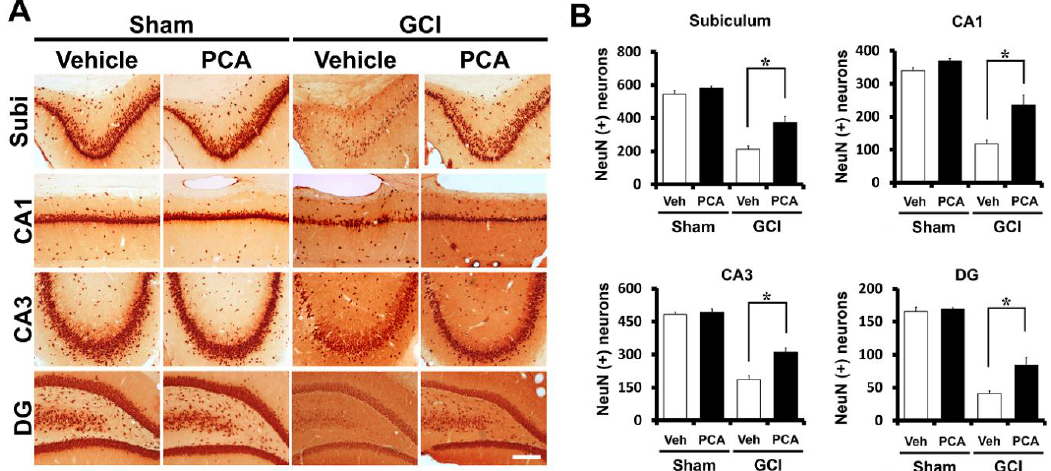
Figure 2. PCA treatment promotes neuronal survival following ischemia. Ischemia-induced neuronal loss was measured by NeuN staining at one week after global ischemia or sham operation. Figure ( A ) representative photomicrographs show significant neuronal loss in the CA1, CA3, subiculum, and DG after ischemia ( n = 9). However, ischemia-induced NeuN (+) neurons were preserved by PCA treatment in the hippocampal regions compared to vehicle treatment. Scale bar = 100 µ m. ( B ) This graph represents the quantitated live neurons (NeuN (+) neuron) in the hippocampus. Data reflect the mean ± S.E.M., n = 5 from each sham group. n = 9 from each ischemia group. * Significantly different from the vehicle-treated group, p < 0.05.